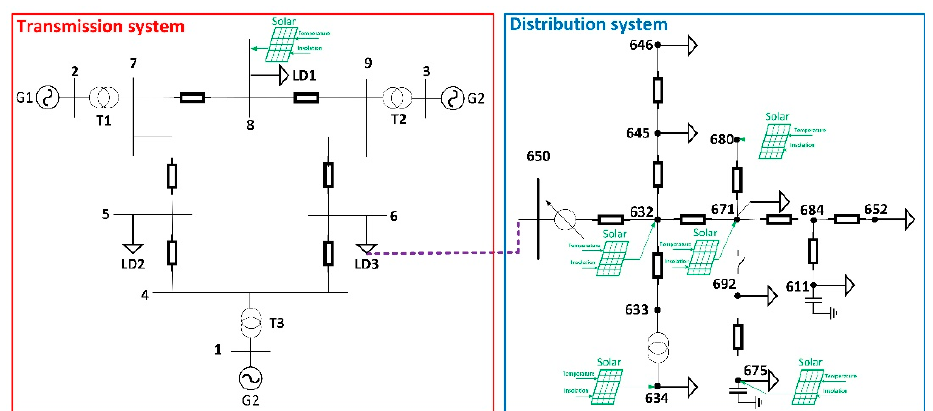
Figure 2. Single-line diagram of the constructed model for real-time electromagnetic simulation.